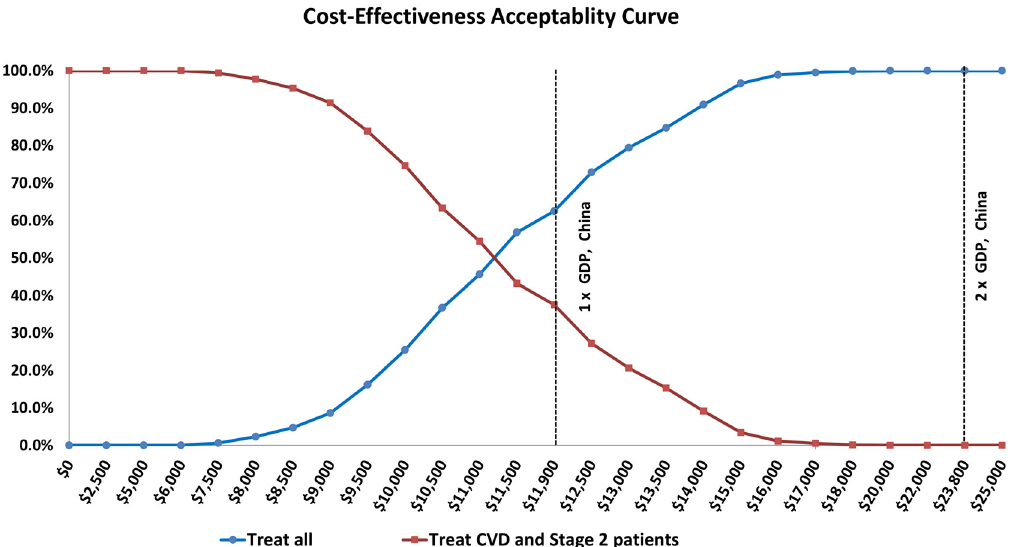
Fig 2. Cost-effectiveness acceptability curves comparing treating all untreated hypertensive adults (blue) with treating only untreated CVD patients and adults with stage 2 hypertension but without CVD (red). The threshold for cost-effective in China assumed for this analysis is labeled at Int $11,900 (China ’ s GDP per capita; conversion to US dollars from Chinese RMB based on PPP). Twice China ’ s GDP is also labelled at